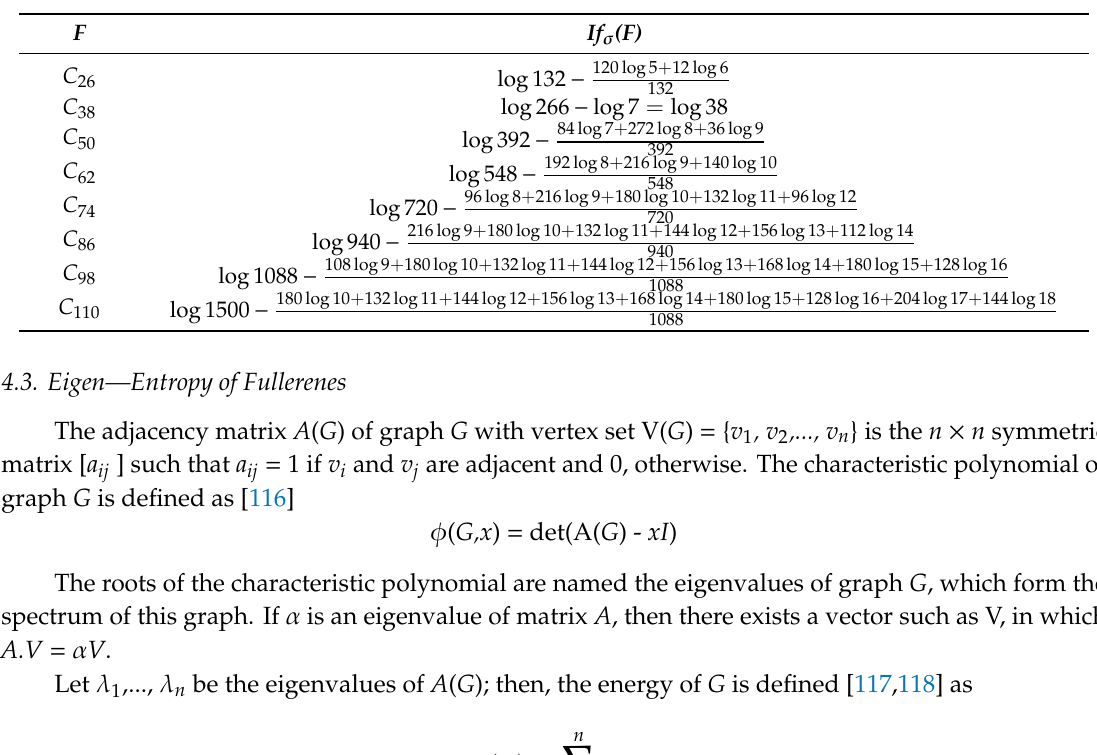
Table 4. Some exceptional cases of C 12 n + 2